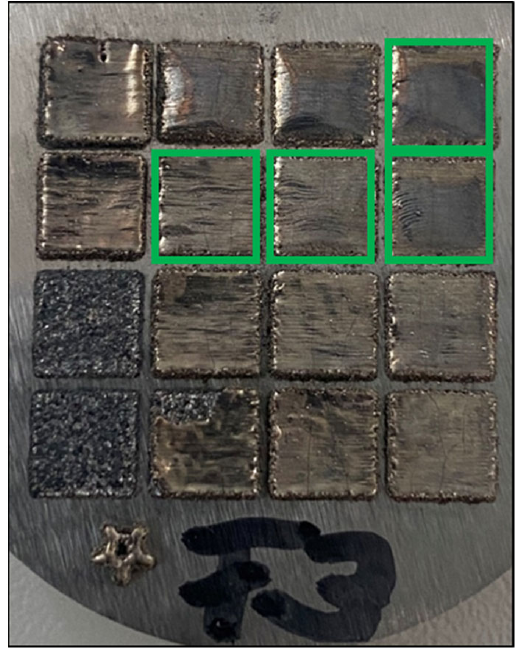
Figure 6. Top view of the PBF-LB samples of the parameter study (parameter settings detailed in Figure 3b). Samples marked in green were used for in-depth microstructural investigations. The etched microstructures of the investigated samples are depicted in Figure